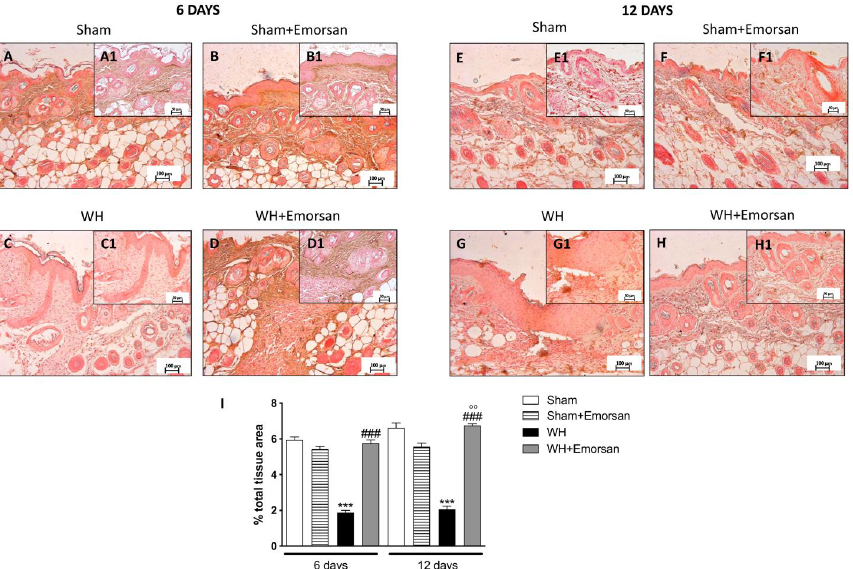
Figure 6. Effects of Emorsan ® Gel on TGF-β levels in the skin after 6 and 12 days from WH in- duction. The epidermal tissues collected from WH-injured animals showed positive immunostain- ing for TGF-β ( C , C1 , G , G1 ,score I ), compared to the sham groups ( A , A1 , B , B1 , E , E1 , F , F1 ,score I ). Emorsan ® Gel topical administration notably reduced TGF-β levels in the skin after 6 and 12 days from WH induction ( D , D1 , H , H1 ,score I ). Data are representative of at least three independent ex- periments. Values are means ± SEM. One-Way ANOVA test. *** p < 0.001 vs. corresponding Sham; ### p < 0.001 vs. corresponding WH; °° p < 0.01 vs. WH+Emorsan 6 days.